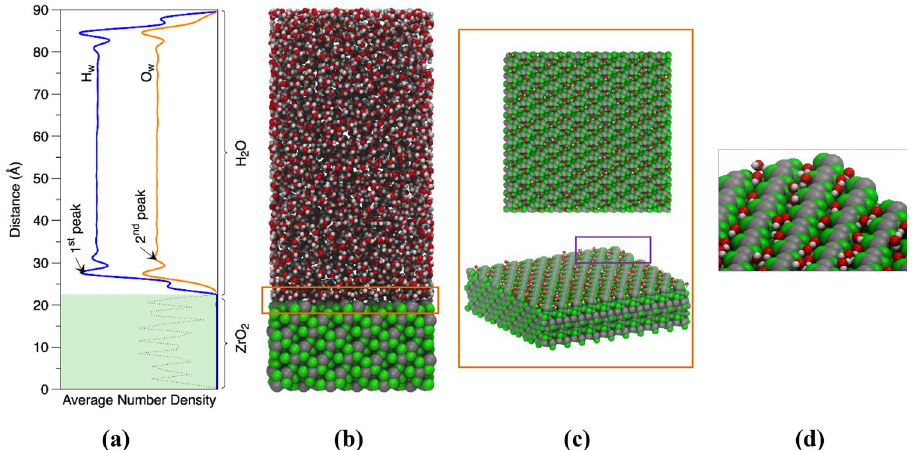
Figure 1. Illustrative representation of the system setup for the MD simulations of hydrophilic (− 111) surface of monoclinic baddeleyite (mZrO 2 ) in equilibrium with water at 396.15 K. ( a ) density profile along the z-axis representing the parallel to zirconia interface solvent layers ( b ) the supercell used for the MD analysis of the heterogeneous water boiling, ( c ) top and perspective view of the (− 111) baddeleyite surface with only the first adsorbed layer of water molecules corresponding to the first oxygen maxima on the density profile and ( d ) magnified view portraying the orientation of the adsorbed water molecules. The oxygen atoms of the zirconia are green, the zirconium atoms are grey, the oxygen and hydrogen atoms of water are red white, respectively. Images were created using Visual Molecular Dynamics (VMD) v1.9.4 47